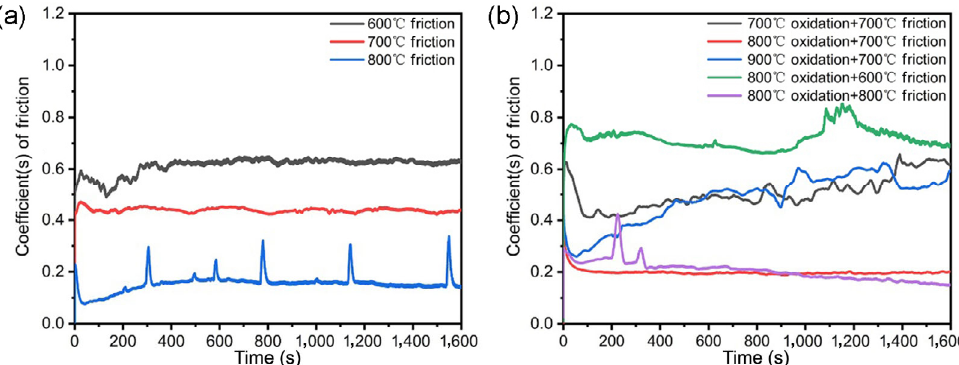
Fig. 2 Friction coefficient of VAlTiCrW films at different temperatures as a function of sliding time (a); friction coefficient of VAlTiCrW films pre-oxidized at different temperatures